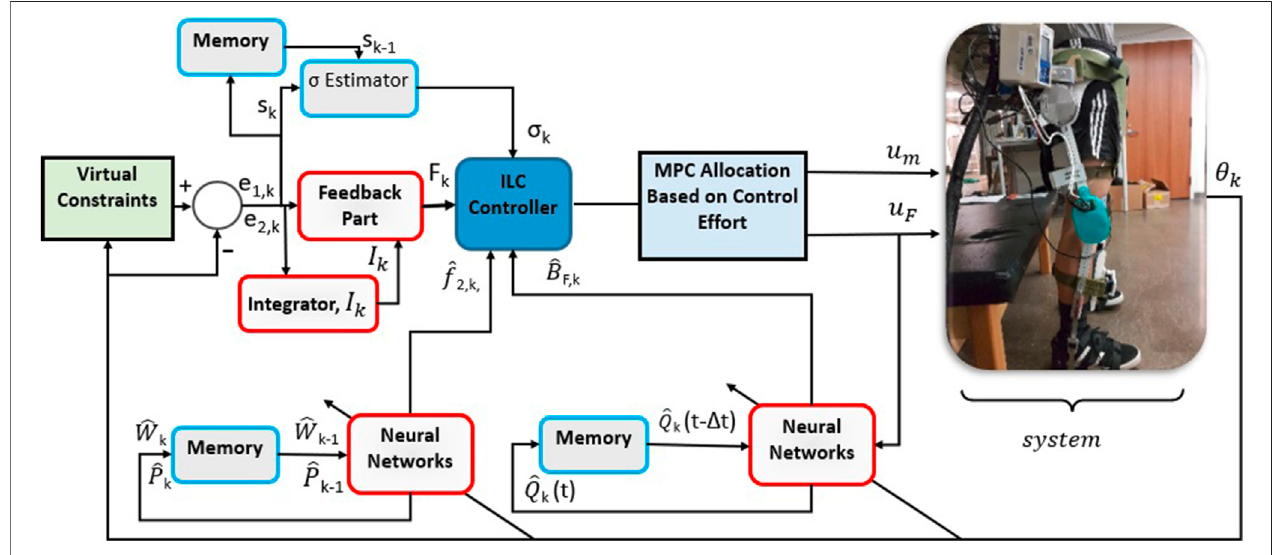
FIGURE 1 | Structure of the proposed controller and the test bed that are used during experiments for the controller validation.